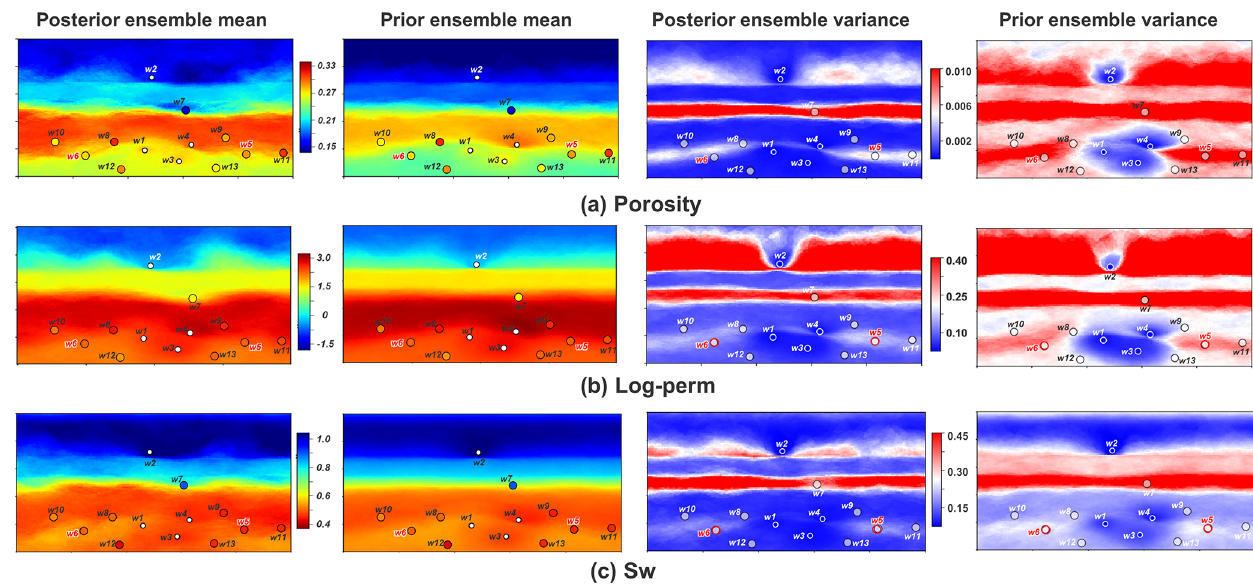
Figure 18. Ensemble mean and variance of posterior and prior geological models: (a) porosity; (b) log-perm; (c) water saturation. The dots represent locations of the boreholes, where the color of the dots represents observation values.